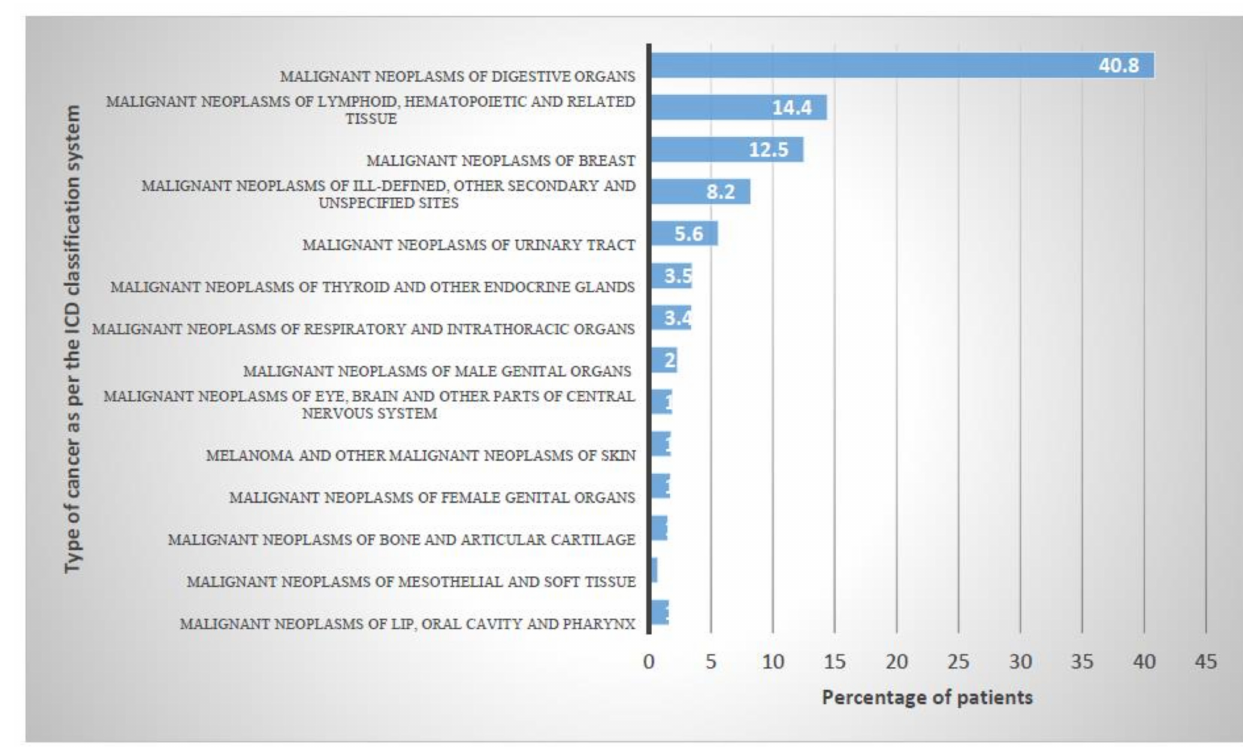
Figure 1. Epidemiology of cancer classified according to the ICD-10 code. The most common three types of cancer were breast cancer, colon cancer, and liver cancer (Figure 2). Figure 3 below present the most common type of cancer stratified by gender.